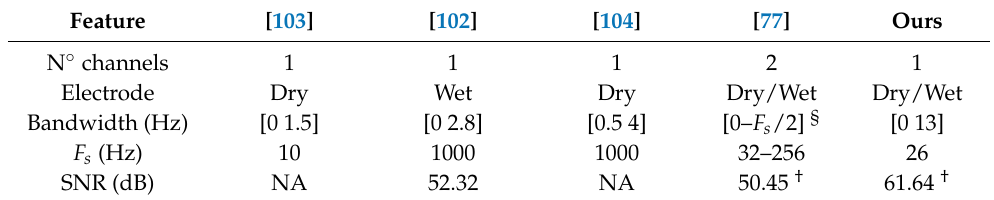
Table 10. Comparative with other low-cost EDA circuits. † SNR for wet electrodes; § The platform does not apply any kind of filtering